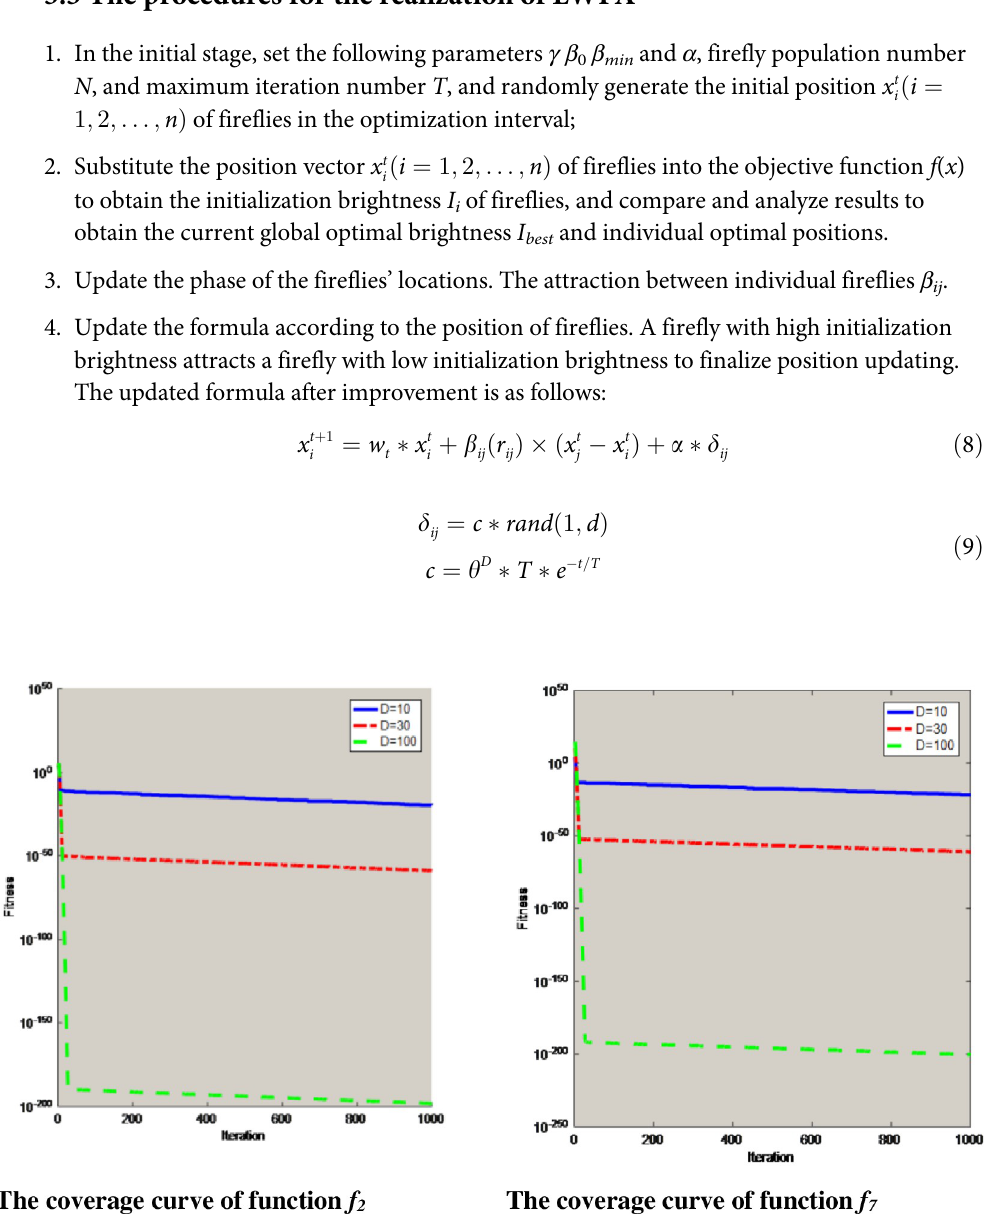
Fig 7. The convergence curves of the function in different